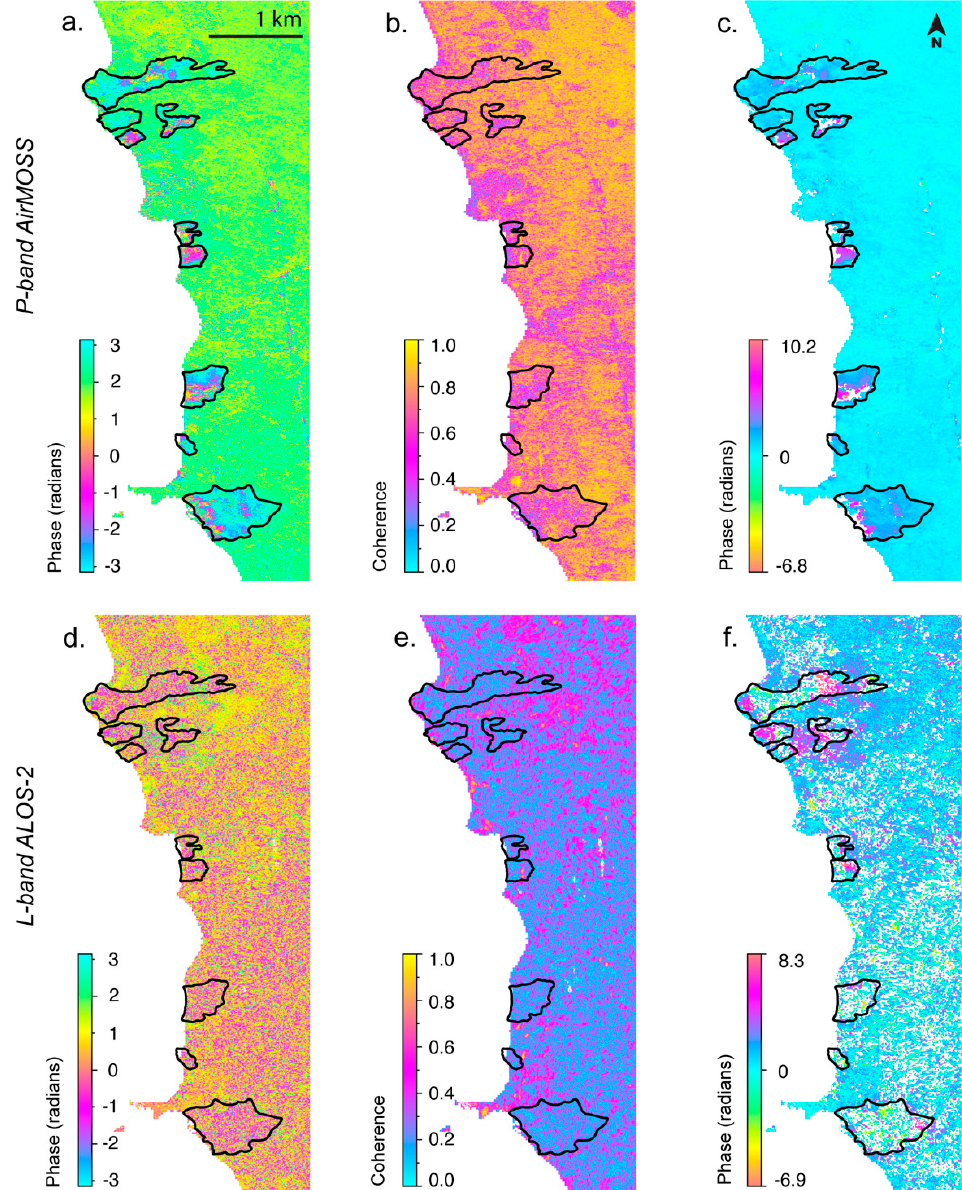
Figure 4. Comparison of L-band and P-band InSAR for geohazard detection. Geographical location of the selected region was depicted by the red box in Figure 2. ( a – c ) illustrate the wrapped interferogram, coherence, and unwrapped interferogram from the P-band AirMOSS acquisitions, respectively. ( d – f ) illustrate the wrapped interferogram, coherence, and unwrapped interferogram of the L-band ALOS-2 SAR images, respectively. The black polygons outline the active landslides, all of which slope towards the Pacific Ocean on the west. The white spots on the unwrapped interferograms represent the masked-out regions with low coherence.